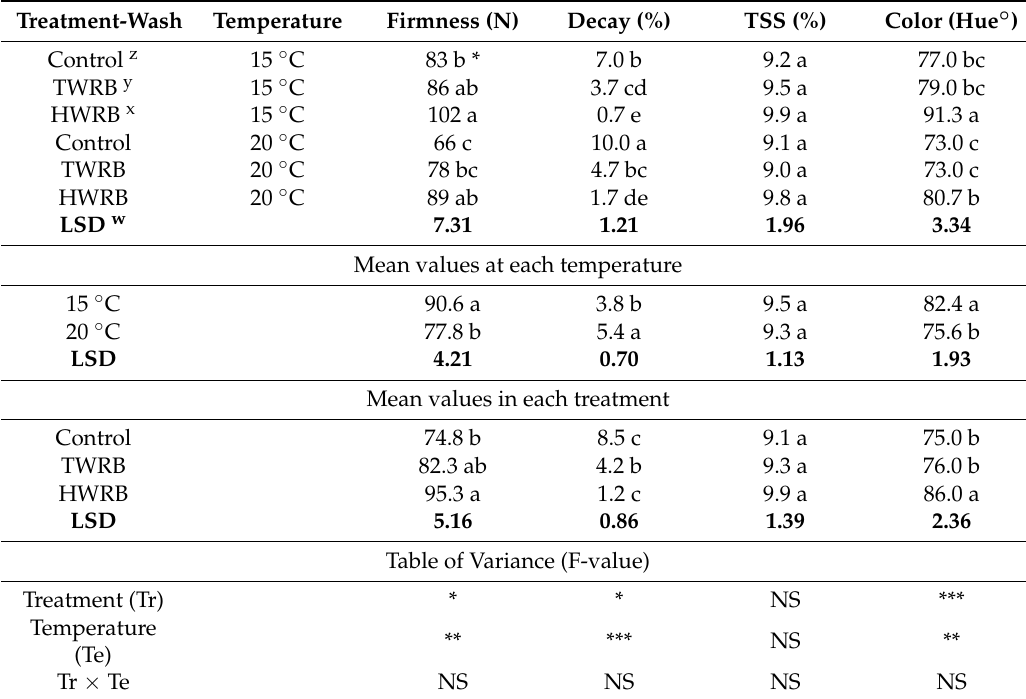
Table 2. The influence of tap water rinsing and brushing (TWRB) and hot water rinsing and brushing (HWRB = 54 ± 1 ◦ C for 15 s) on Acorn squash quality parameters after 3.5 months at 15 or 20 ◦ C plus 3 days at 20 ◦ C.